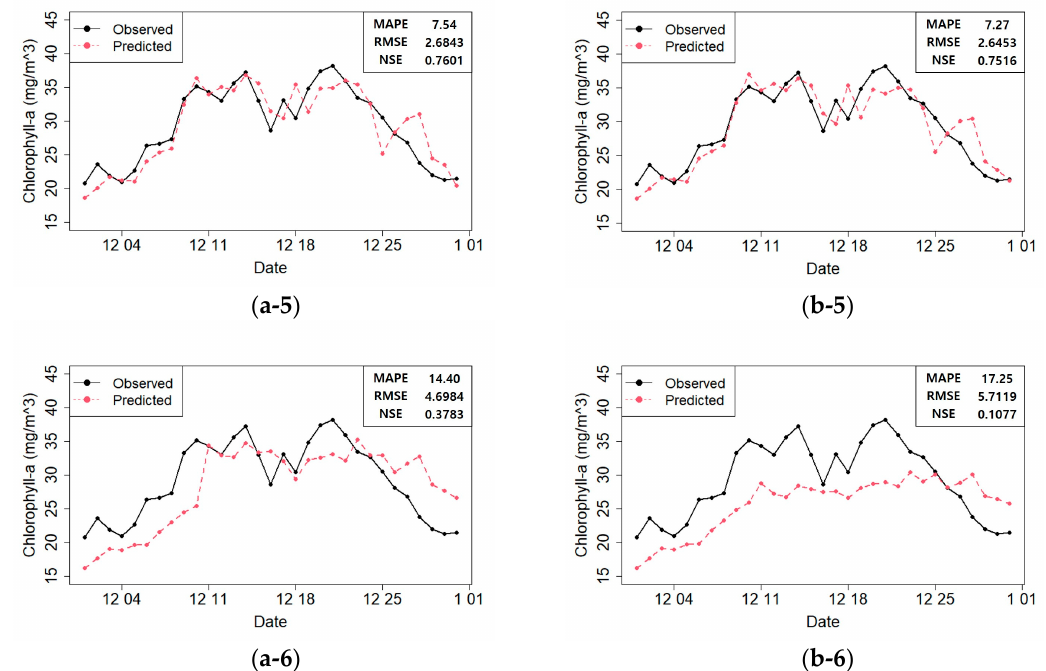
Figure 10. Prediction results for riverine chlorophyll ‐ a concentrations of the final model using only the selected variables via forward selection; 1–step ahead recursive predictions with ( a ) cumulative learning and ( b ) rolling window learning; (1) Support Vector Regression (SVR), (2) Bagging, (3) Random Forest (RF), (4) Extreme Gradient Boosting (XGBoost), (5) Recurrent Neural Network (RNN), and (6) Long–Short ‐ Term Memory (LSTM).